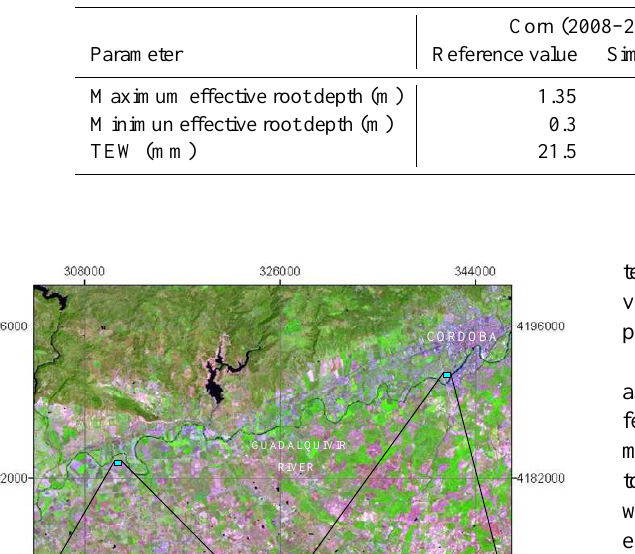
Table 4. Sensitivity analysis parameters: reference values and ranges.